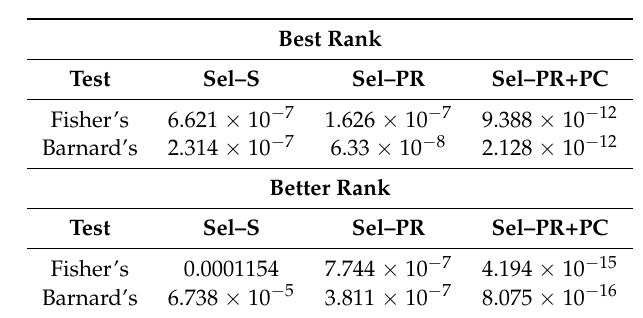
Table 6. Comparison of Size + Energy (S+E) to other selection strategies on best rank via 1-sided Fisher’s and Barnard’s tests. Top panel evaluates the null hypothesis that Sel-S+E does not provide the best rank (based on reported p-values), considering each of the other three selection strategies in turn. Similarly, the lower panel evaluates the null hypothesis that Sel-S+E does not provide a better rank with respect to another particular selection strategy, considering each in turn.